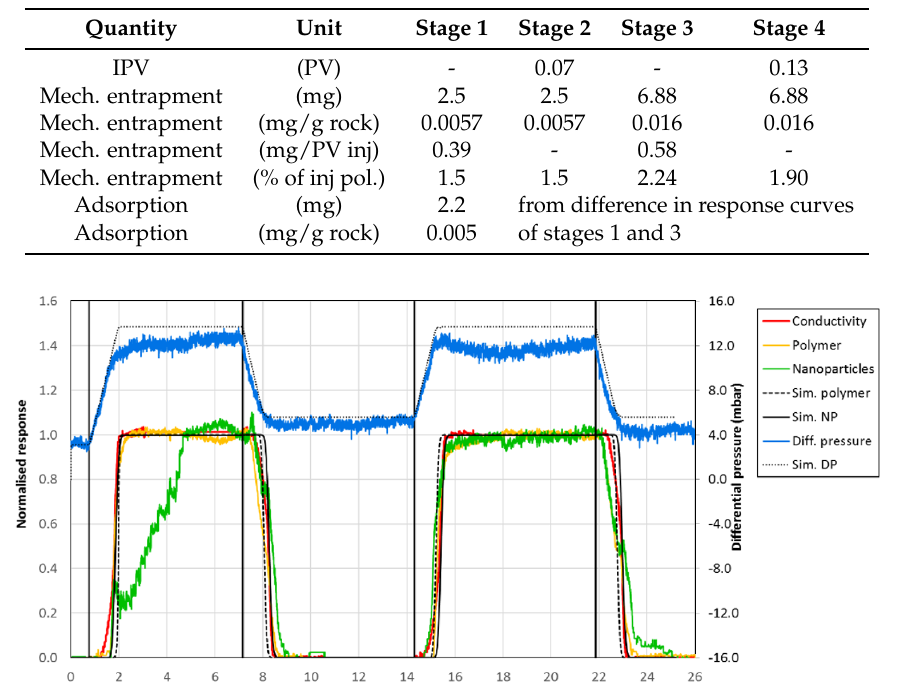
Figure 12. Comparison of the experiment and simulation of co-injection of nanomaterials and polymers (Experiment 3 with Bentheimer): The nanomaterial response during the first injection slug in the experiment is assumed to be wrong. Conductivity measurements from the experiment and differential pressure over the core are also